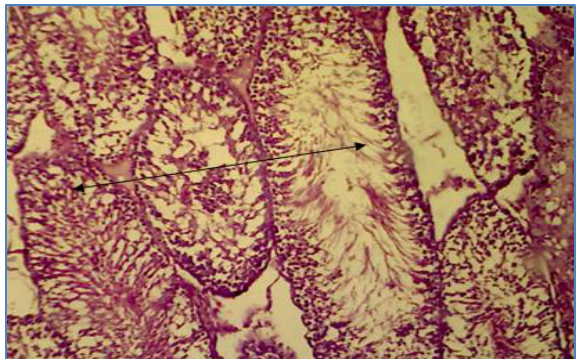
Figure, 18: Section in testis of animal treated with Eruca Sativa (G3). Shows normal arrangement of seminiferous tubules ( ) with complete spermatogenesis (H and E stain